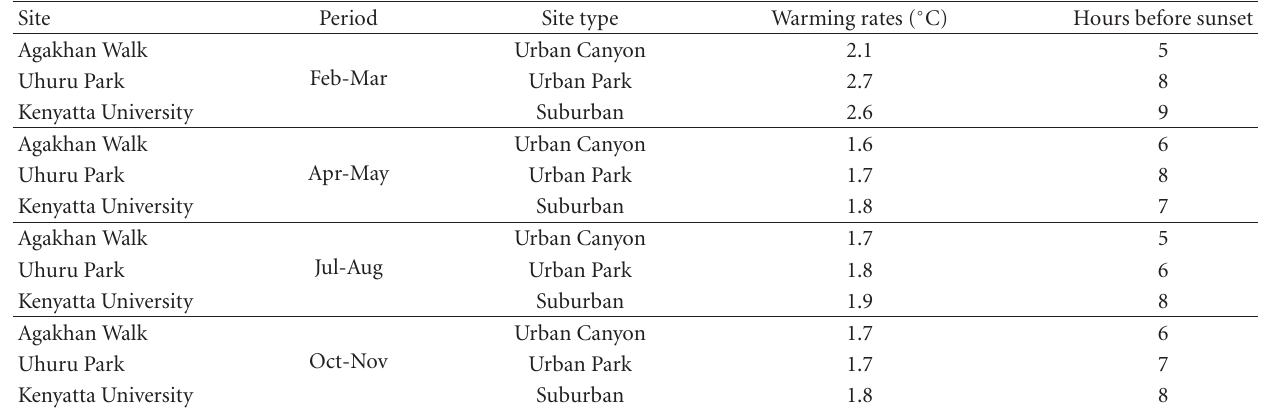
Table 2: Highest warming ( ◦ C/hr) rates before sunset for three sites in Nairobi